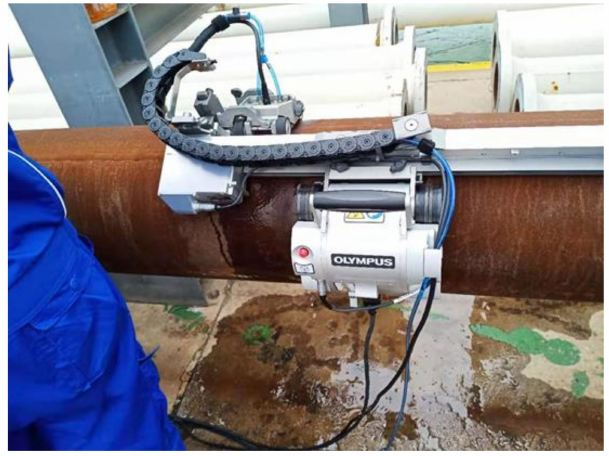
Figure 3. The experiment